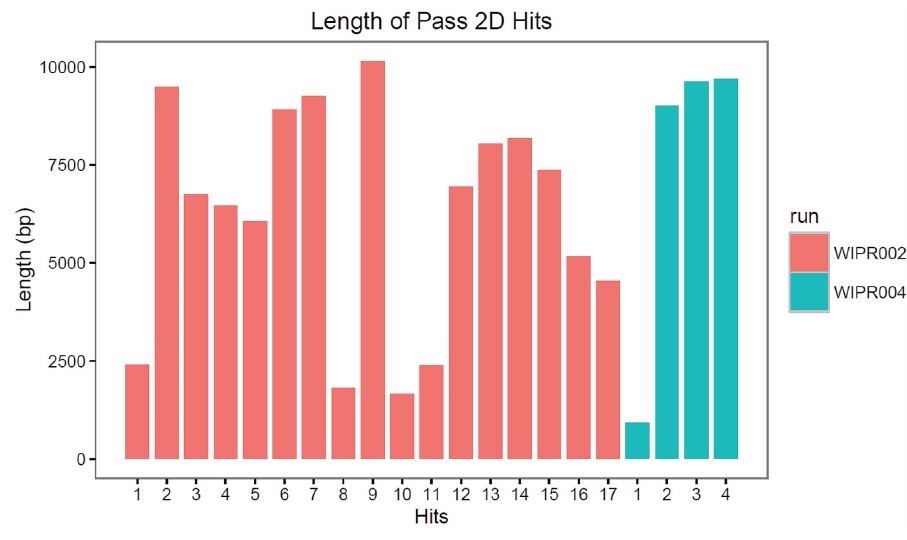
Fig 2. The length distribution of the 2D